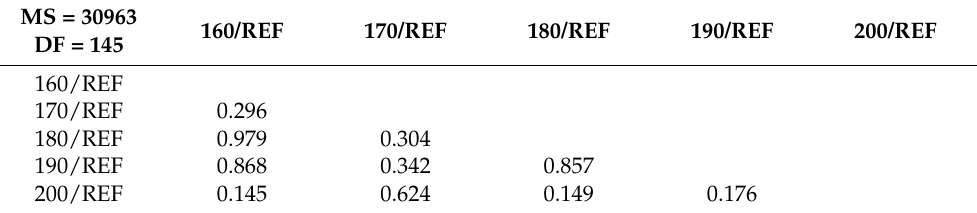
Table A13. Duncan ´ s multiple range test for changes in degree of gloss at 85 ◦